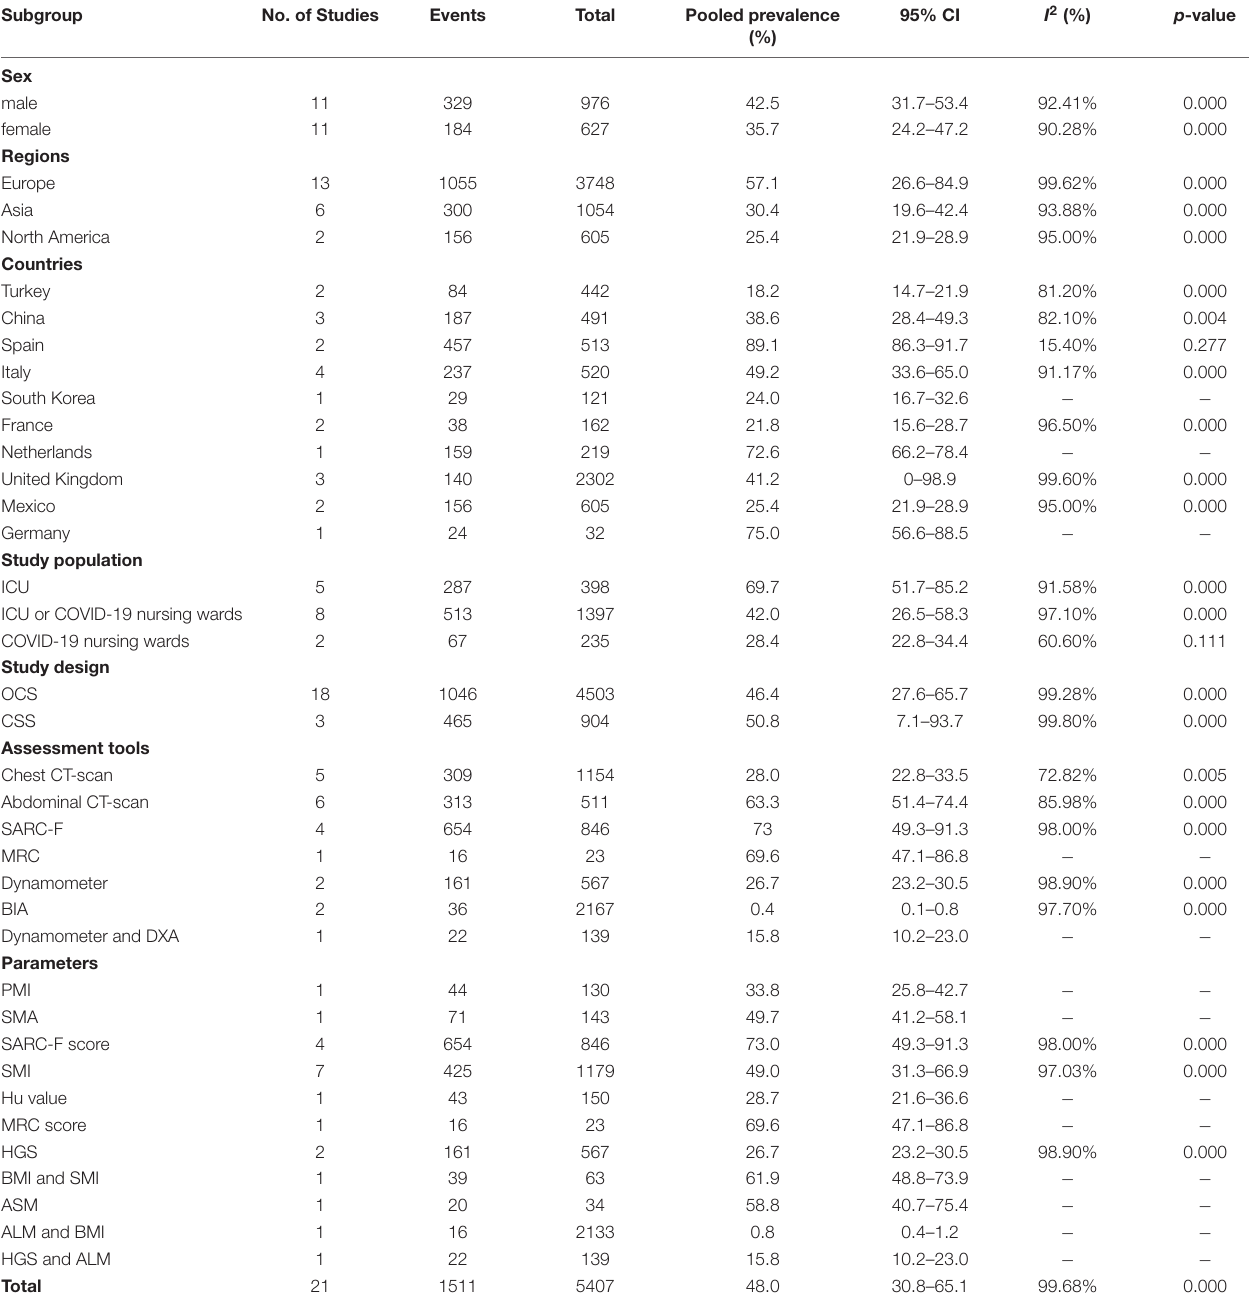
TABLE 3 | Subgroup analysis of the prevalence of